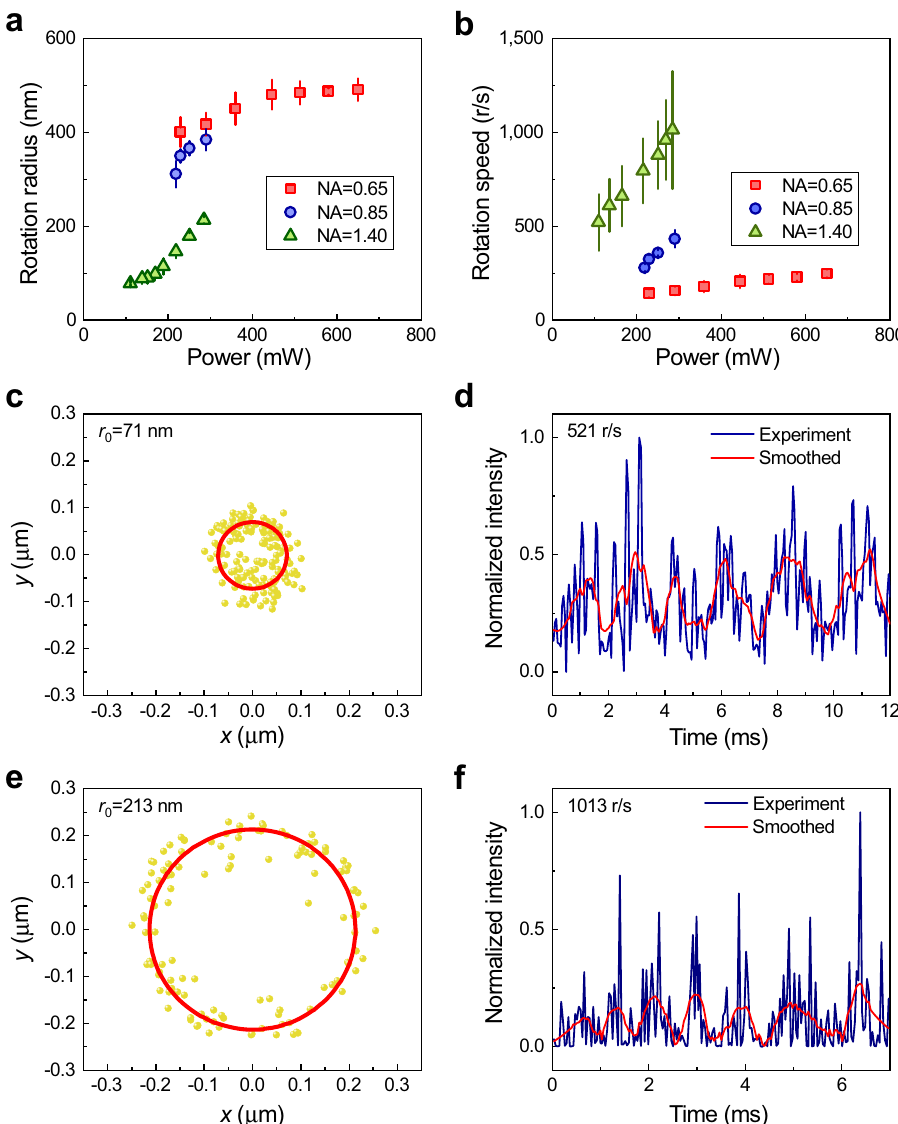
Fig. 2 Experimental results for the high-frequency rotation at sub-diffraction scale. a Dependence of the orbital radius of the trapped particle (also the radius of the scattering light ring) on the mean laser beam power P with different NA lens, the rotation radii of particles under different NA are different. b Dependence of orbital speed of GNP on the mean power of trapped laser with different NA lens. With the control of the NA, we can control the rotation speed. In Fig. 2a, b, the standard deviation bars are included. c Two-dimensional trajectory projection on the xy -plane of an orbiting particle for the smallest orbital radius (about 71 nm) obtained in our experiments. d The intensity of the scattering light from the rotation particle when the radius of 71 nm is measured by the PMT. In Figs. (c, d), the mean power P of trapping laser beam is about 100 mW, NA = 1.40. e , f The same cases as in Fig. 2c, d, show the fastest orbital rotation (about 1013 Hz, the corresponding radius 213 nm) achieved in the experiments, where the mean power of the laser beam is about 285 mW, NA =